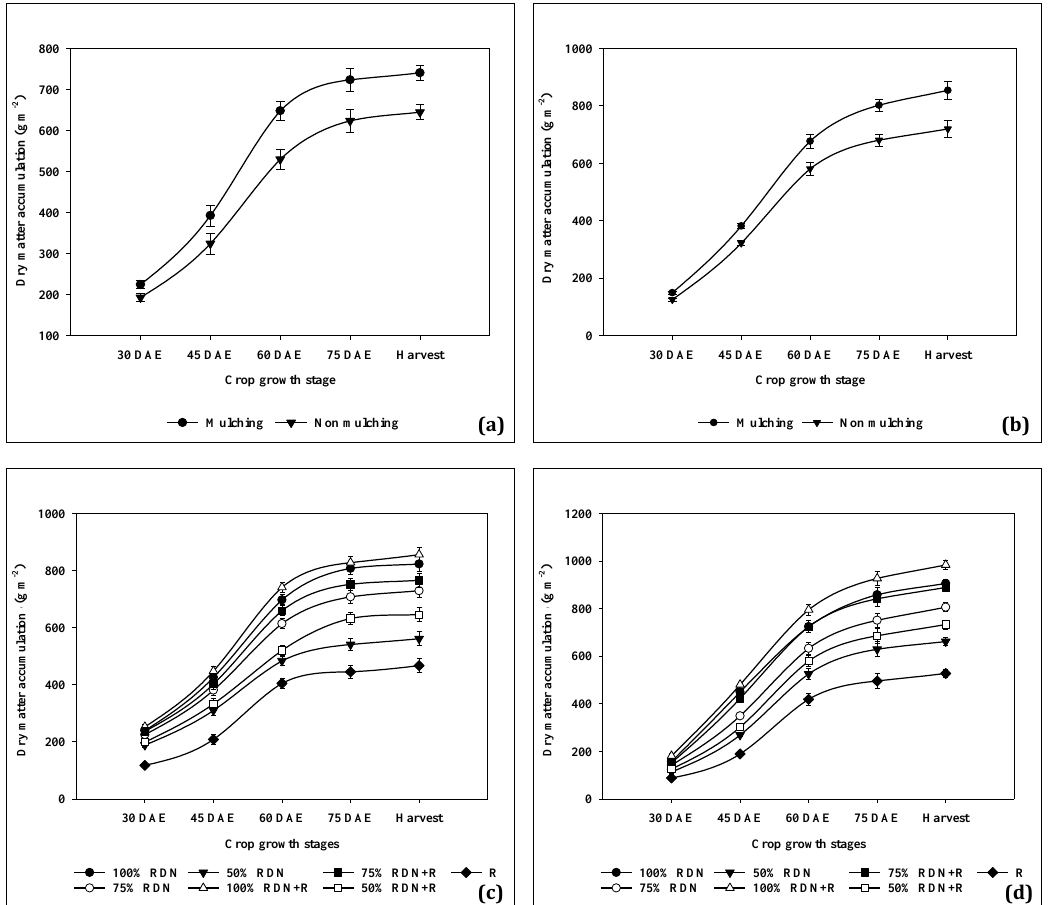
Figure 3. Effect of soil mulch ( a , b ) and nutrient management ( c , d ) on peanut aboveground dry matter accumulation at different growth stages (data from 2015–2016 and 2016–2017 crop seasons, respectively). DAE—days after emergence; error bars represent the least significant difference values.